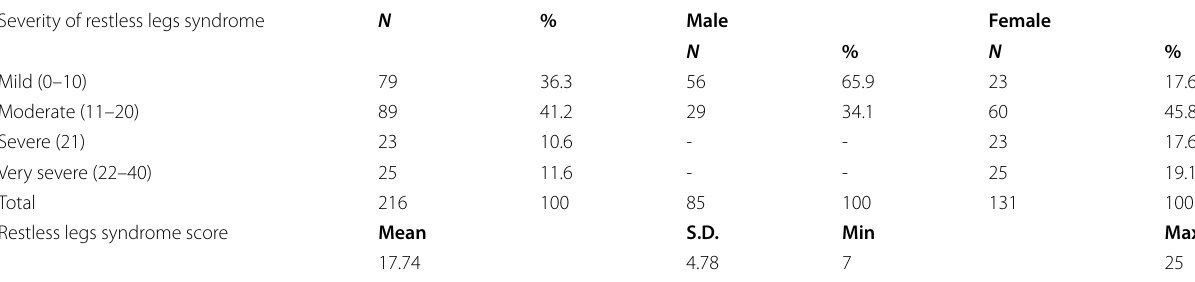
Table 2 Severity distribution of restless legs syndrome in workers under study Severity of restless legs syndrome